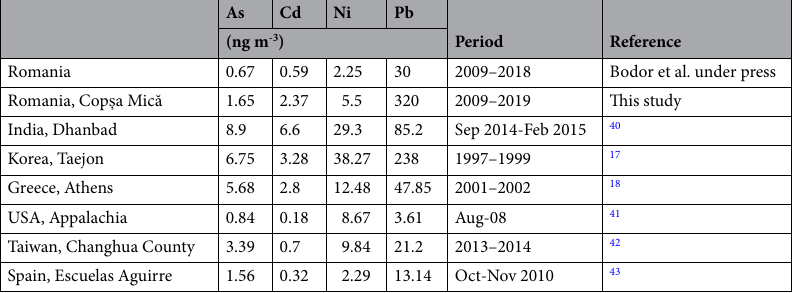
Table 2. Trace elements concentration from PM 10 (ng m -3 ) in different regions around the world.